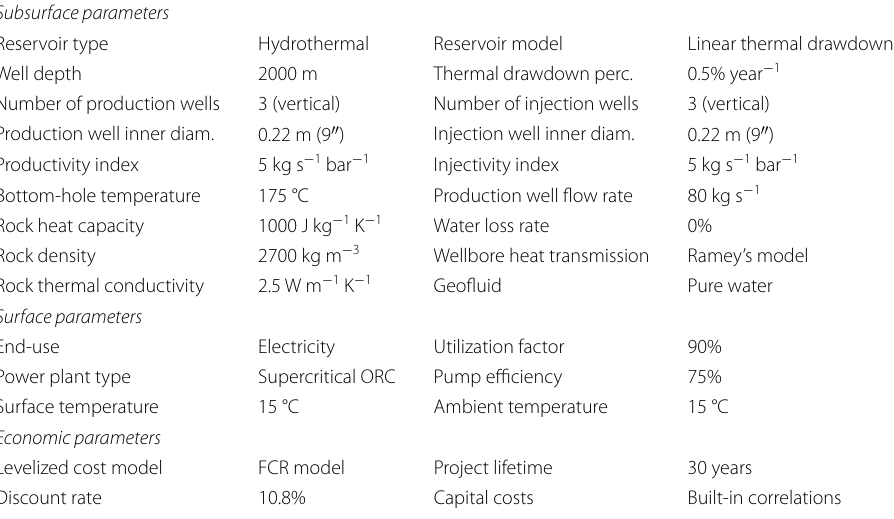
Table 3 GEOPHIRES input parameters for example simulation 2 Subsurface parameters